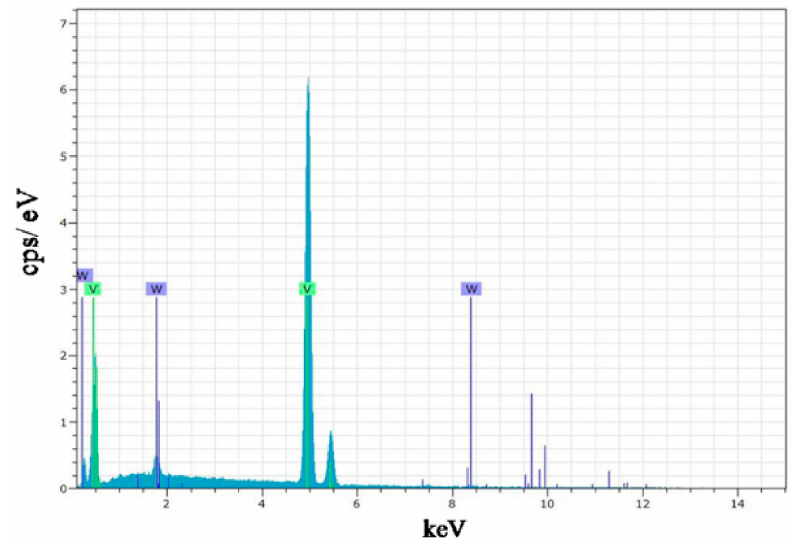
Figure 6. EDS pattern of the W-doped VO 2